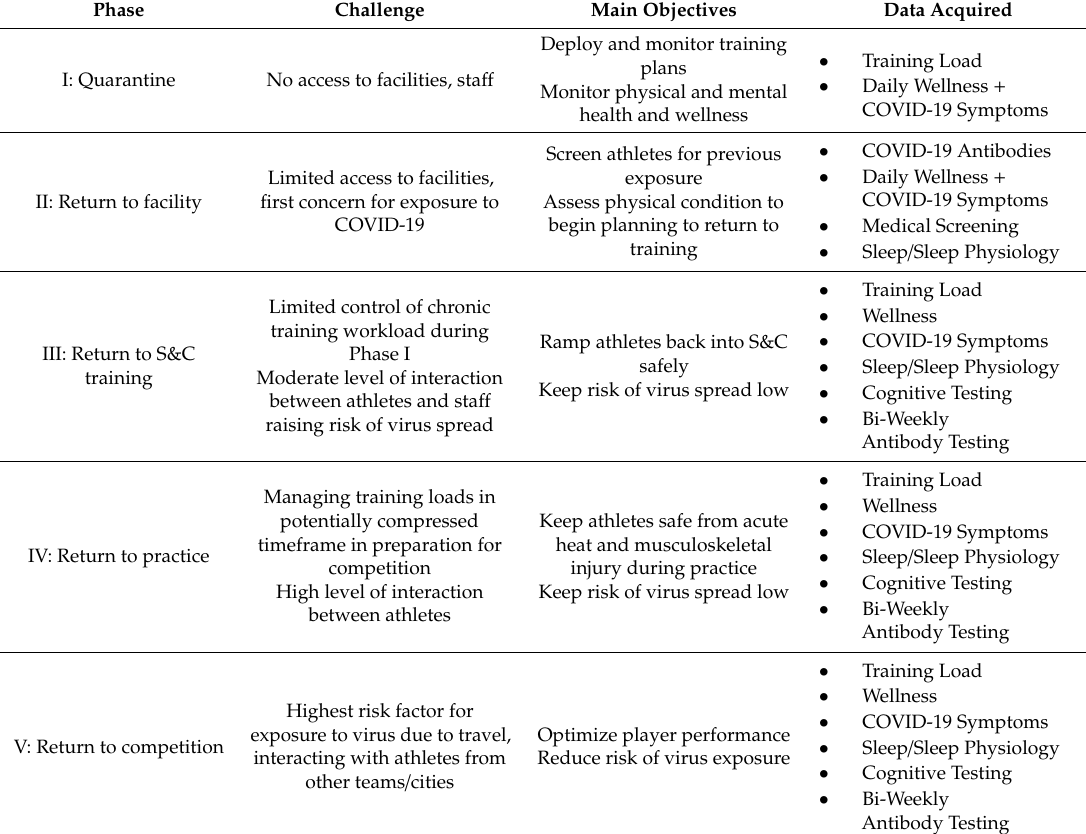
Table 2. Phases of COVID-19 in Return to